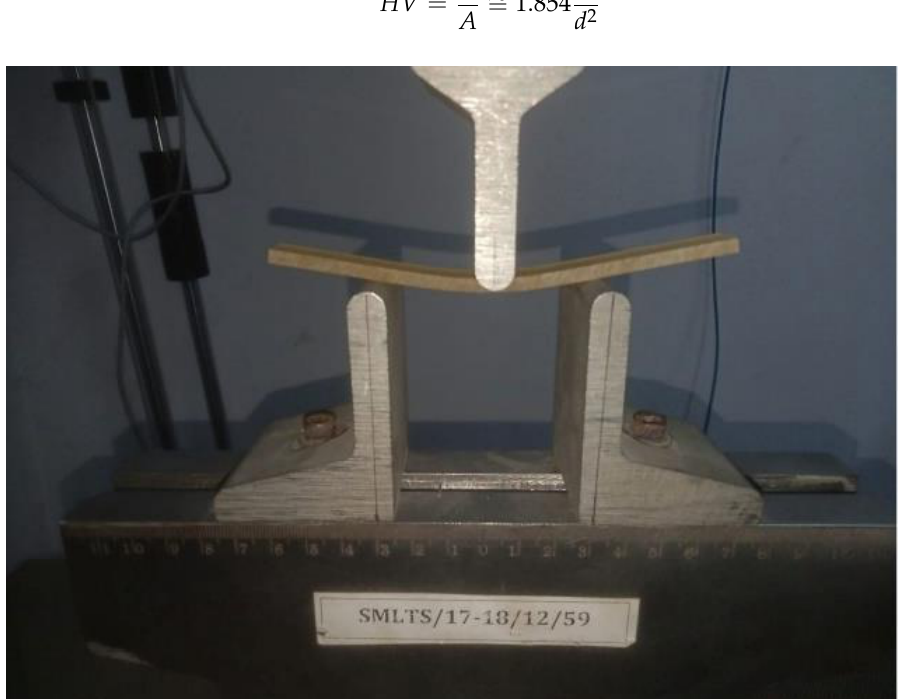
Figure 4. Equipment setup for flexural test specimen in a computerized universal testing machine from DAK system incorporation.